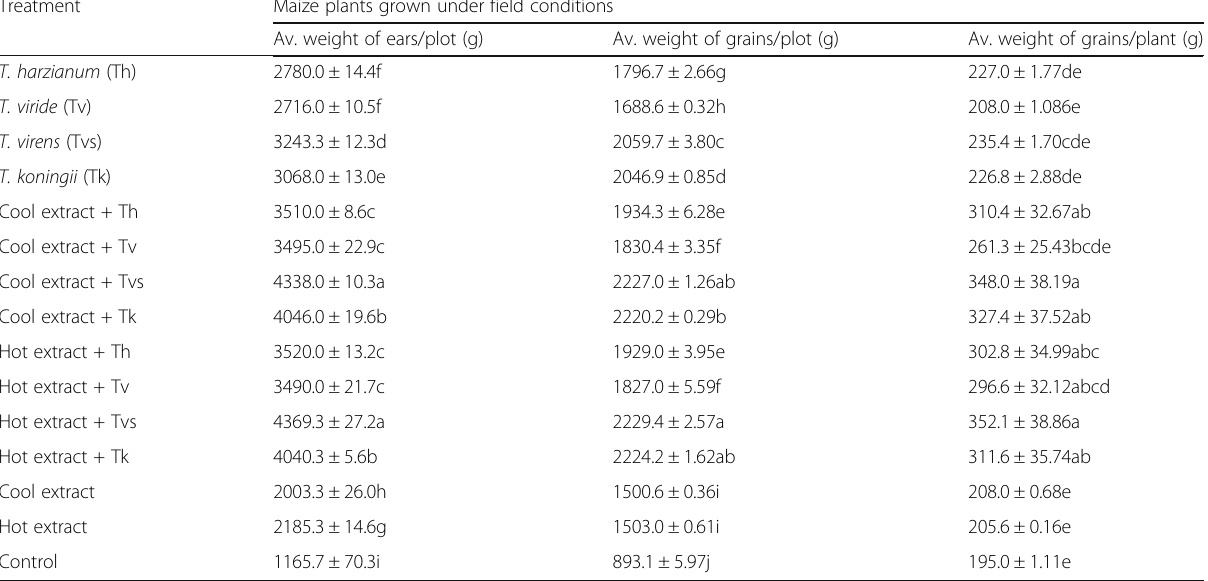
Table 6 Effect of Trichoderma spp. alone or in combination with Chlorella vulgaris extract on yield of maize plants grown under field